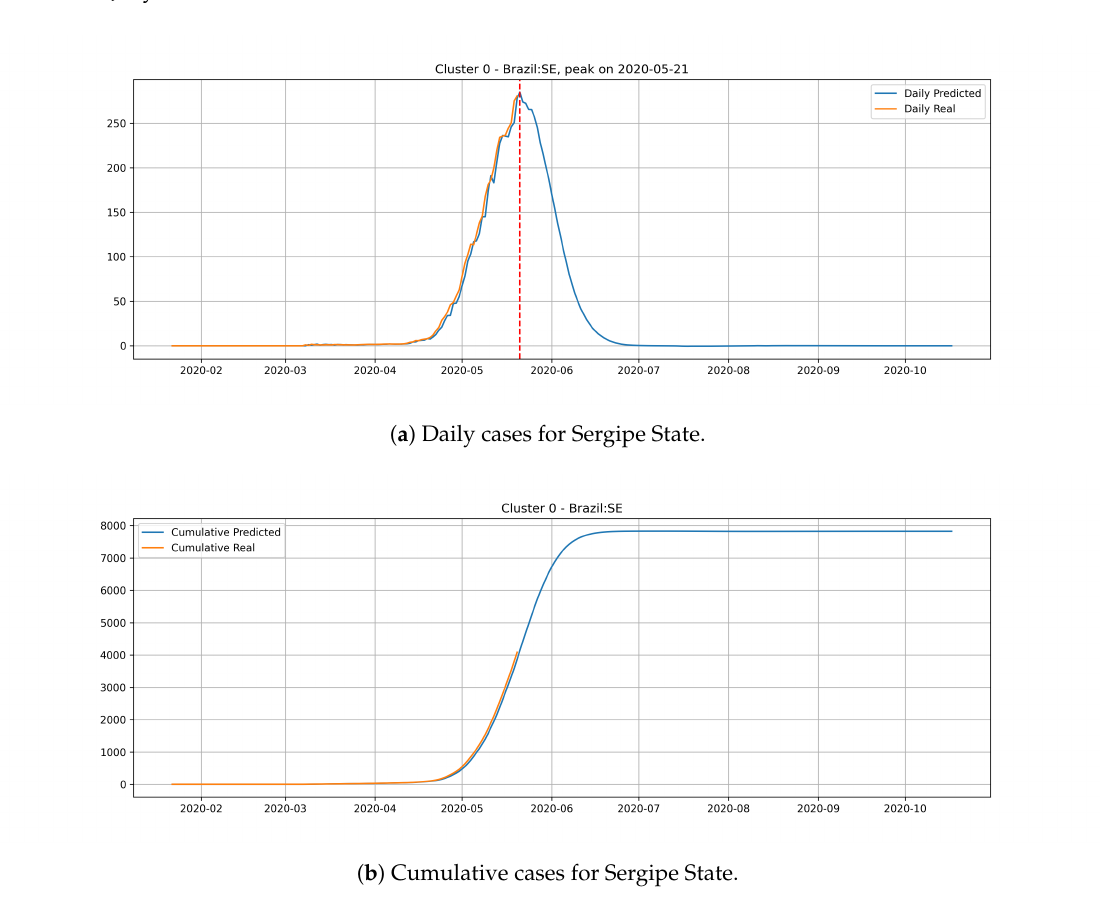
Figure 14. Daily and Cumulative cases for Sergipe State from the Cluster